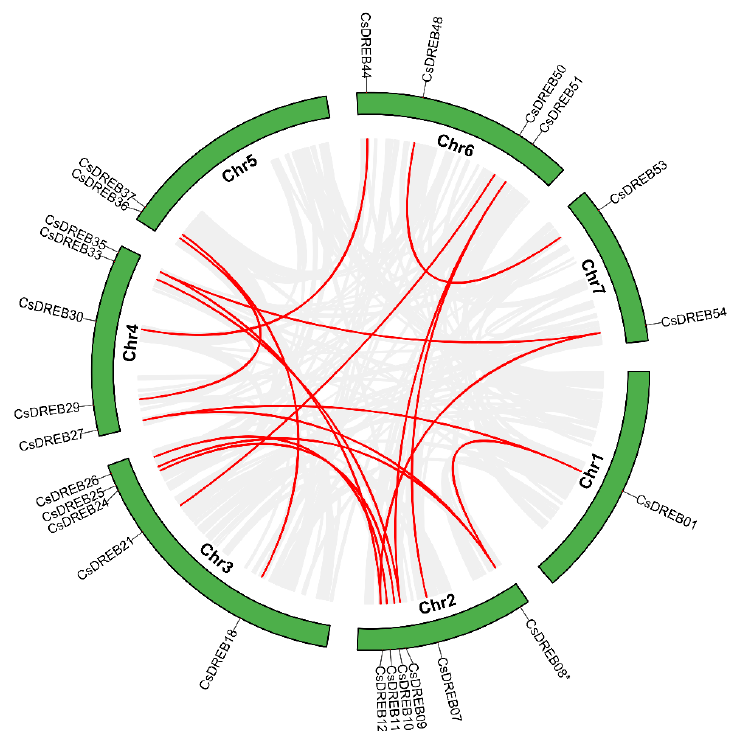
Figure 4. The cis-acting elements of the DREB genes: TC-rich repeats, defense- and stress-responsive elements; WUN-motif, wound-responsive element; LTR, low-temperature-responsive element; DRE, dehydration-responsive element; HSE, heat-stress-responsive element; GARE, gibberellin-responsive element; SARE, salicylic-acid-responsive element; ABRE, abscisic-acid-responsive element; ARE, auxin-responsive element; MeJA-RE, methyl-jasmonic-acid-responsive element. The gray numbered line at the bottom represents promoter length.